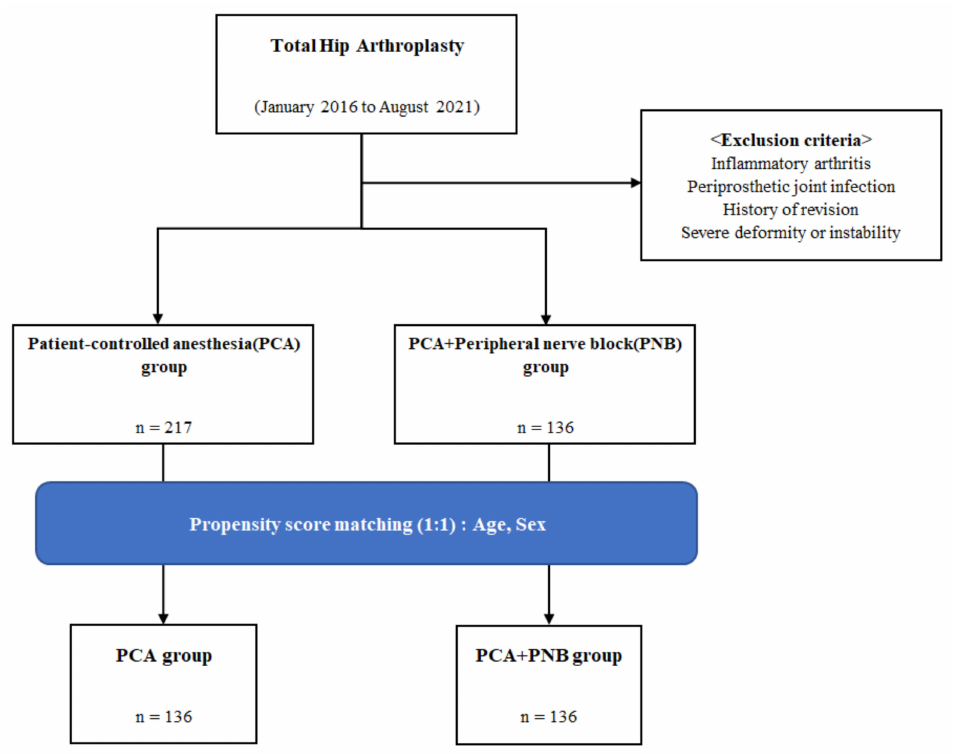
Figure 1. Flow chart for patient